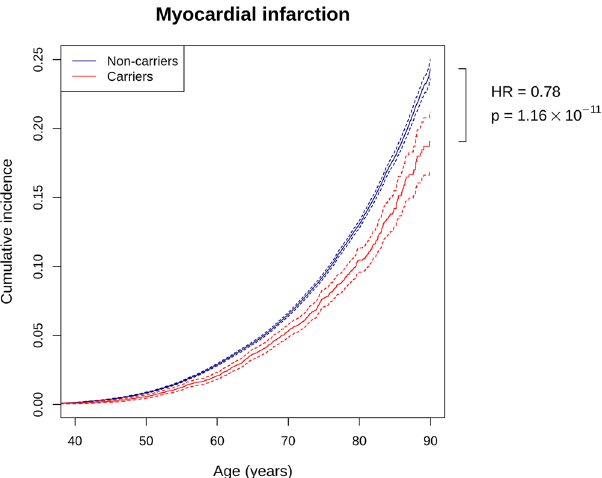
Fig. 6 Cumulative incidence plots for fi rst event of myocardial infarction in FinnGenR6. Red line represents carriers (homo- or heterozygous) for either rs534125149 or rs201988637 ( n = 17,838), and blue line represent non-carriers ( n = 242,567). Hazard ratio and p -value are from cox- proportional hazards model. Dashed lines represent 95% con fi dence